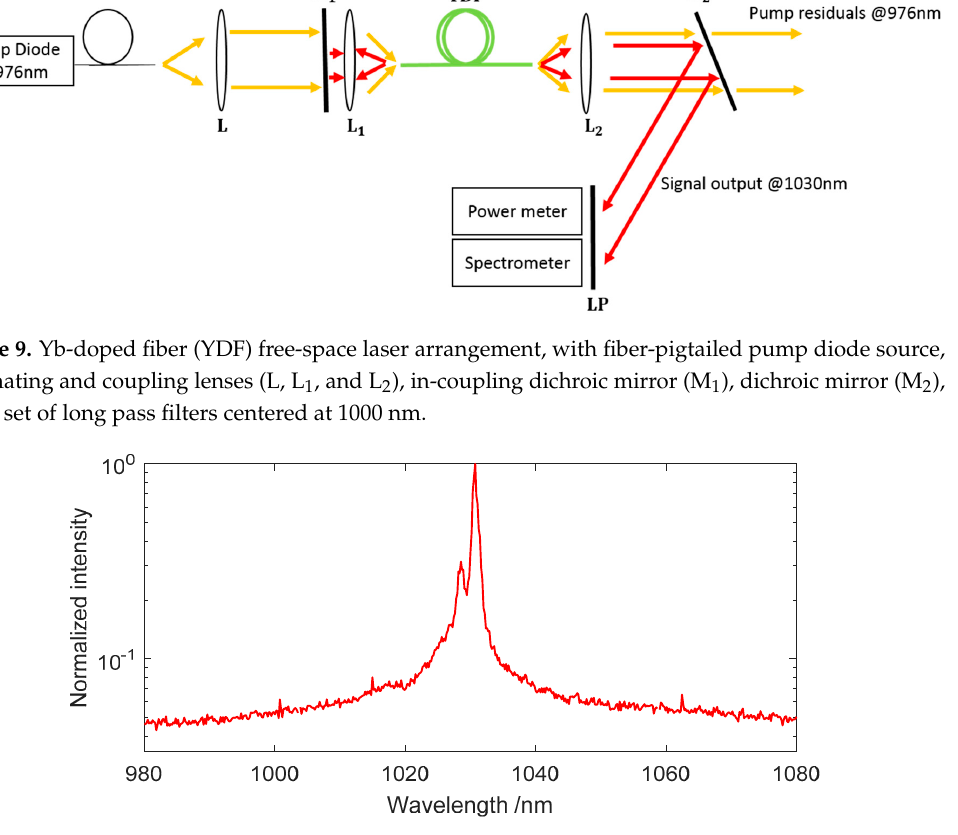
Figure 10. Laser output spectrum of B1200 fiber derived from the sol-gel granulated silica method, with an emission peak at around 1031 nm (log scale).